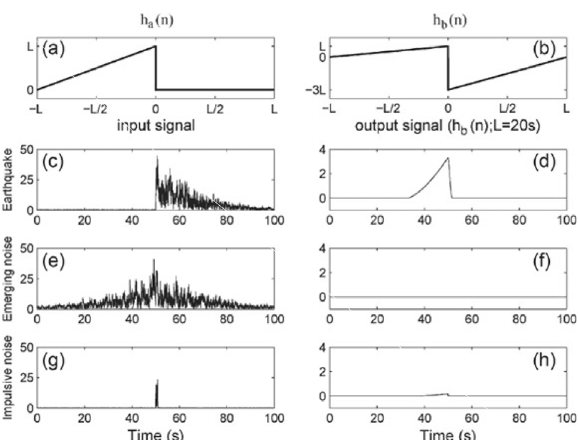
Figure 9. (a) Theoretical impulse response of an optimum detector for inputs with a sharp start and a smooth decay. (b) Impulse response of the optimum detector referred in (a), increasing its penalty for smooth starts. (d), (f) and (h) are examples of characteristic functions (CF) obtained respectively for the example inputs earthquake -(c)-, emerging noise -(d)- and impulsive noise